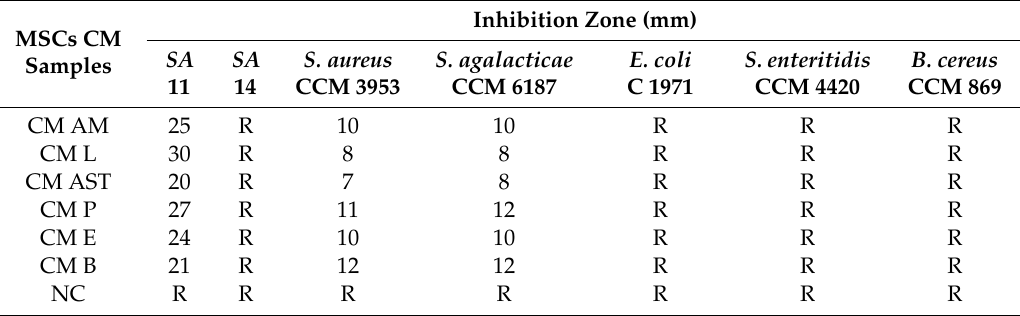
Table 1. Antibacterial